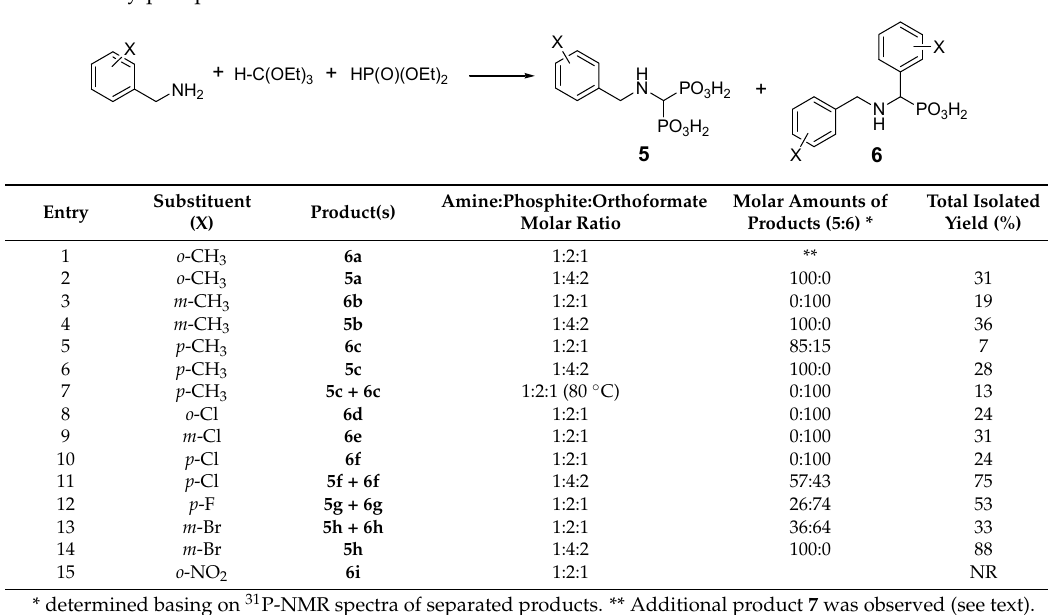
Table 2. Products of the reactions between substituted benzylamines, triethyl orthoformate and diethylphosphite.